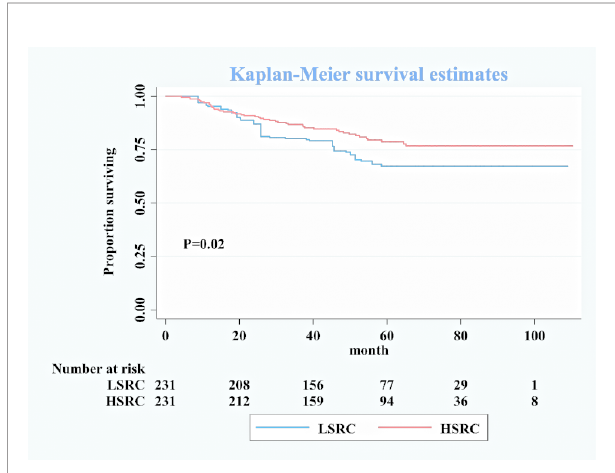
FIGURE 1 | Kaplan – Meier survival curves for overall patients between low-proportion signet ring cells and high-proportion signet ring cells after